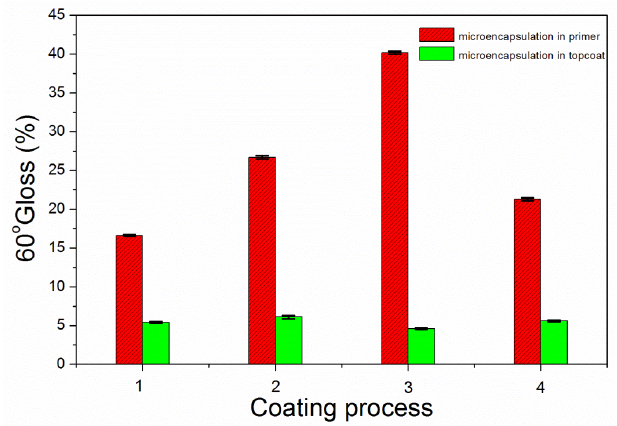
Figure 9. Gloss variation of coating at 20 incident angle (samples 1–4 from Table 1).